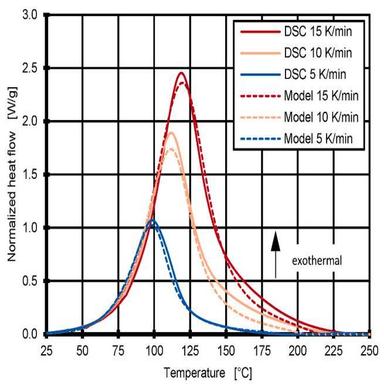
Comparison of experimentally determined and modeled curing reaction at different heating rates.